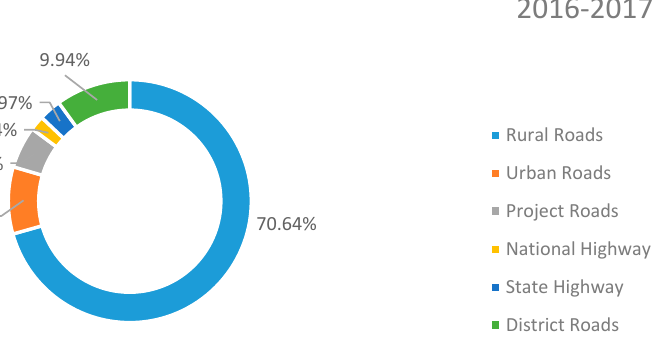
Figure 4. Road length in percentage of different types of roads in India for the period 2016–2017 [49].